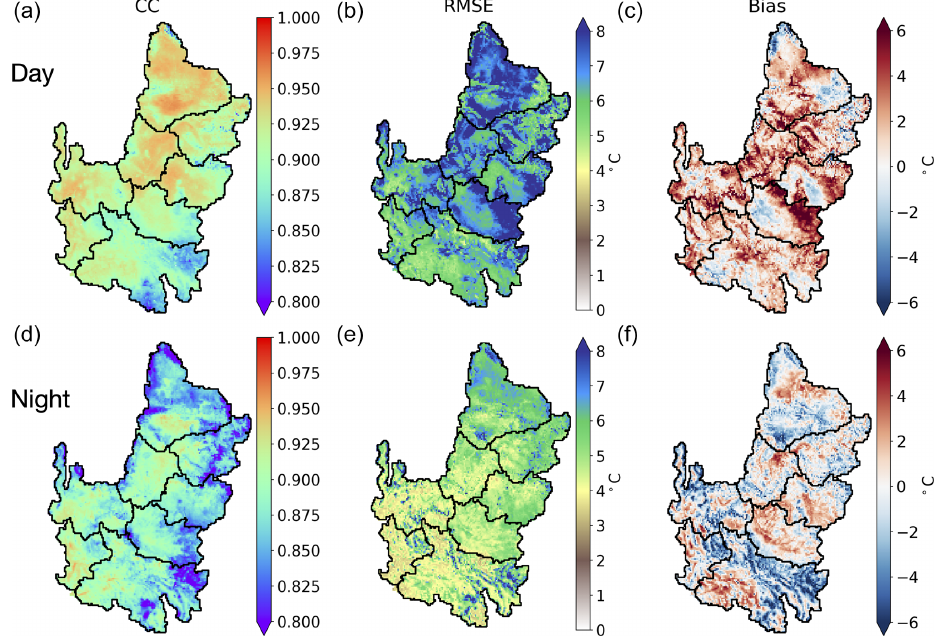
Figure 5. Spatial maps of (a, d) CC, (b, e) RMSE, and (c, f) bias between time series of LST V and LST M over 2003–2018 at each pixel. The top (bottom) row presents daytime (nighttime)